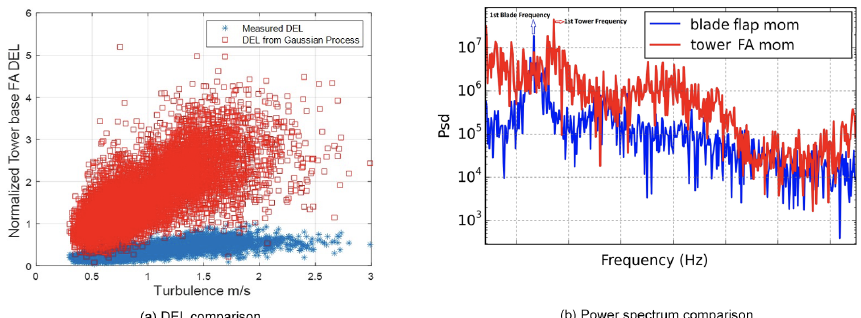
Figure 9. (a) Comparison of the 10min tower base fore–aft damage equivalent moment with measurements at 7ms − 1 using the Gaussian process method without Vanmarcke correction. (b) Comparison of the power spectrum of the tower base moment showing the small increase in energy at its first peak with the corresponding much larger peak in the blade root flap moment.